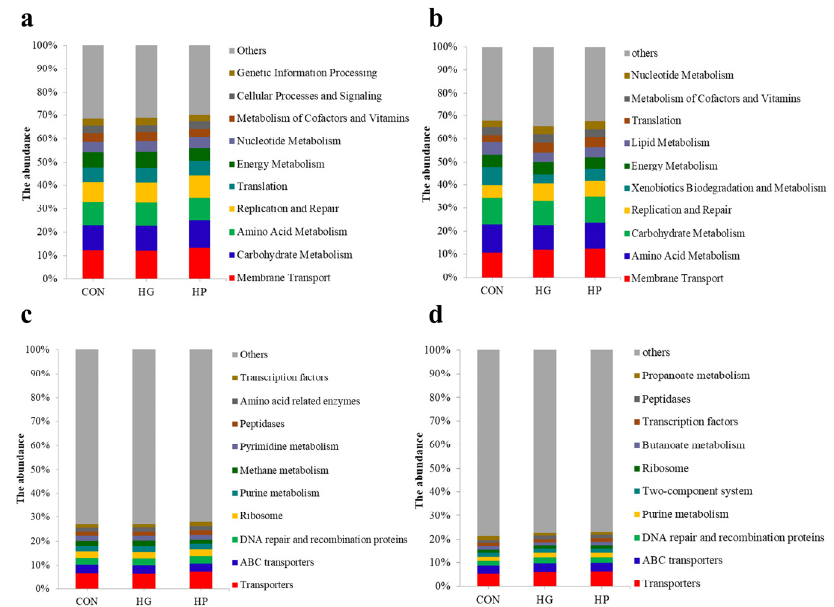
Figure 4. The metabolic profiles of jejunal digesta- and mucosa-associated microbiota at the KEGG level 2 ( a , b ) and 3 ( c , d ) in Hu sheep (n = 5).